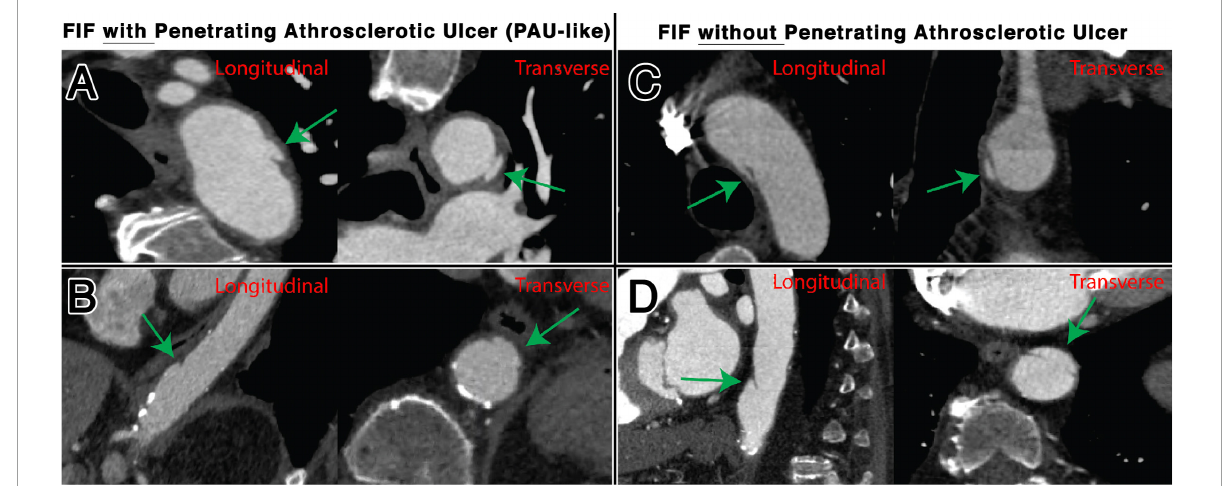
FIGURE4 Representative examples of FIFs, with and without associated PAU, located in the thoracic aorta, shown transverse and longitudinal plane. Locations and characteristics of FIFs shown include distal aortic arch with PAU (A) , distal descending thoracic aorta with PAU (B) , mid arch without PAU (C) , and distal descending thoracic aorta without PAU (D) .